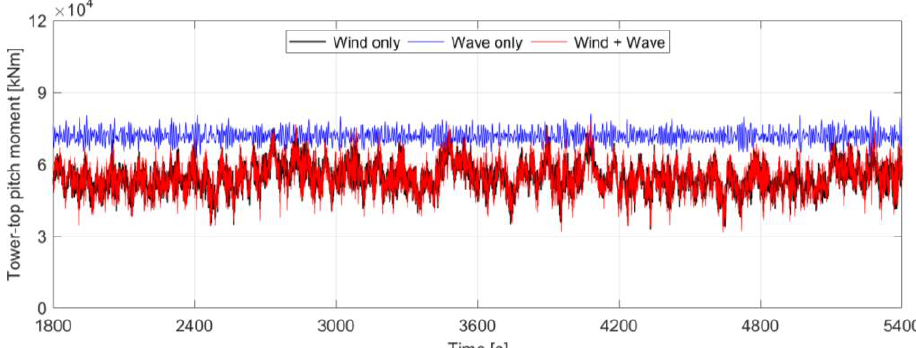
Figure 5. Time series of the tower-top pitch moments for the three specified conditions.